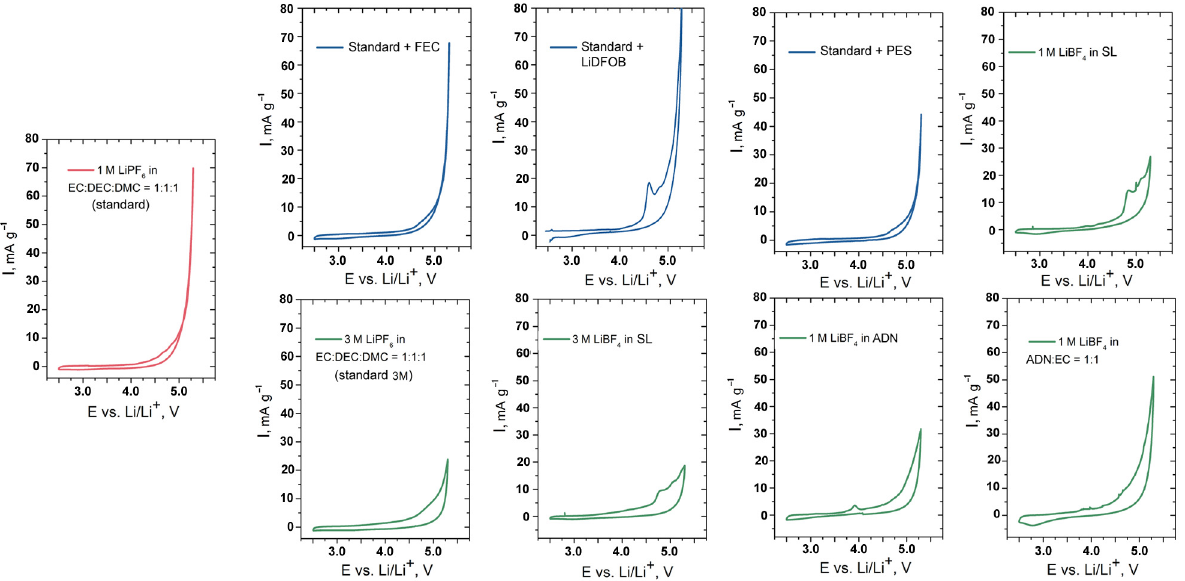
Figure 1. CV curves of the selected electrolytes with “idle” electrodes. The mass fraction of all additives was 1% with the exception of LiDFOB (0.05%). Table 1. Specific anodic current at three points (4.5, 5.0 and 5.3 V vs. Li/Li + ) during the first cycle of CV measured for the electrolytes with “idle” (C + PVDF) working